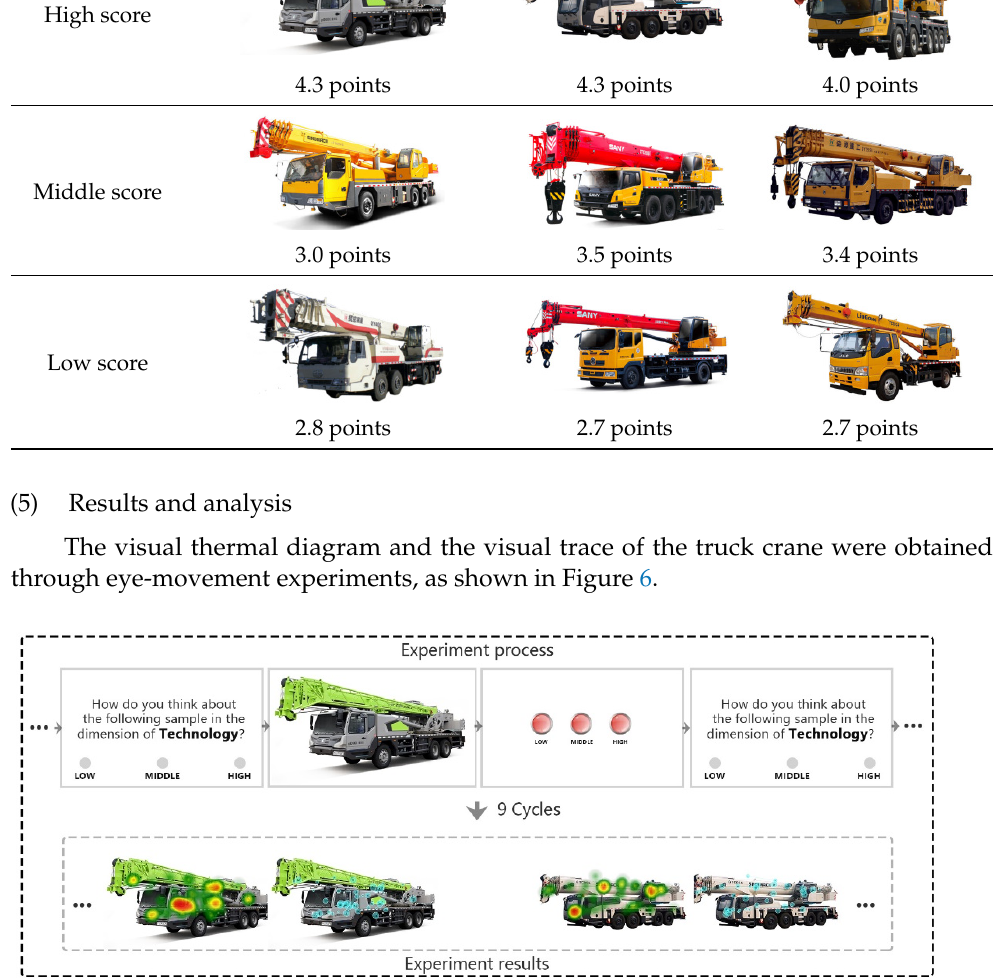
Figure 5. Procedures and results of the eye-movement experiment. Figure 5. Proce dure s and results of the eye-movement experiment.